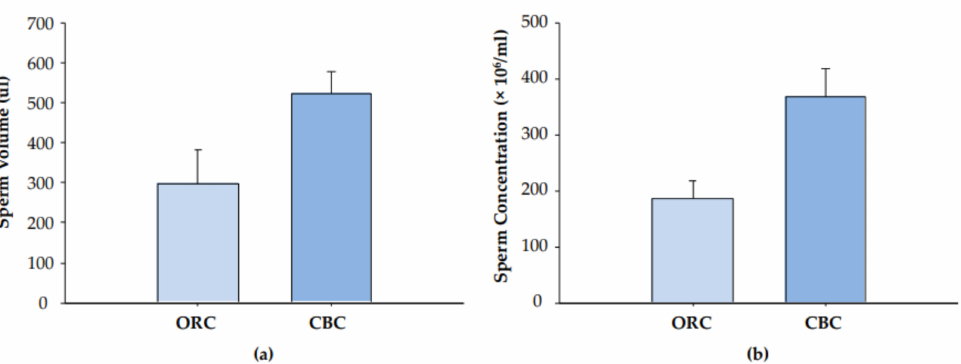
Figure 3. Sperm volume ( a ) and concentration ( b ) from monkeys restrained in either the ORC ( n = 7) or the CBC ( n =